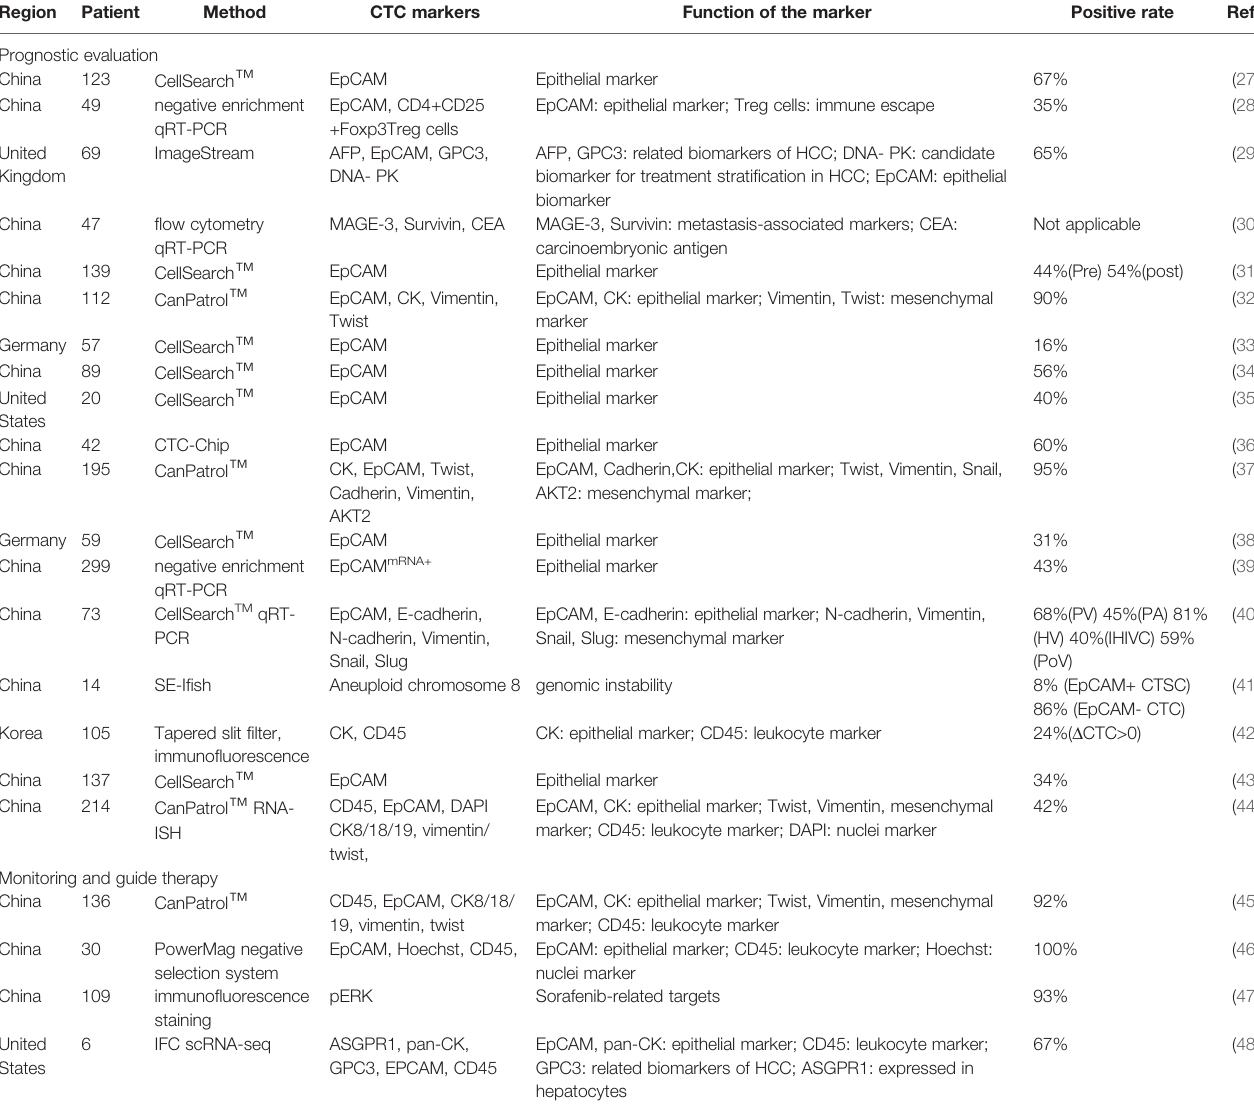
TABLE 1 | Clinical applications of CTC in HCC. Region